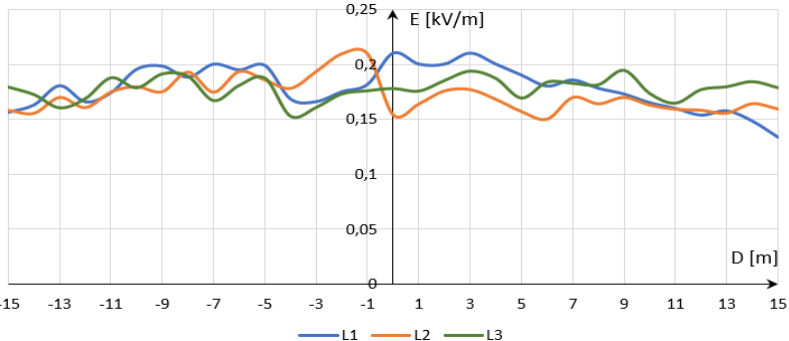
Figure 14. Distribution of electric field strength E along L1, L2, L3 phase conductors of the 15 kV container power line, ELF frequency range (measurement methodology as in Figure 2).